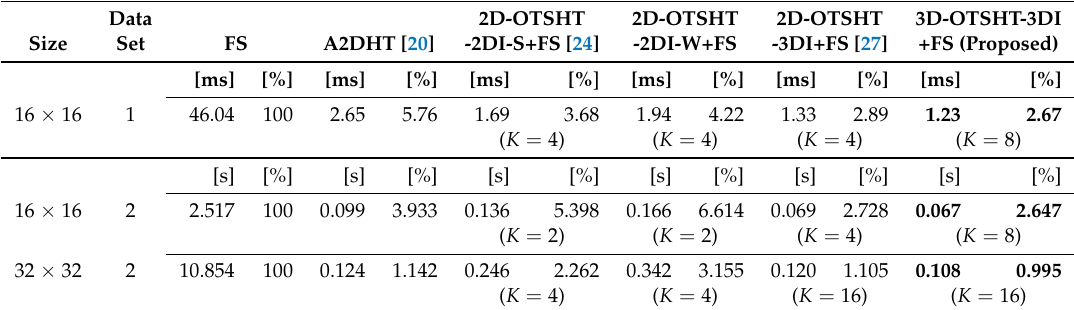
Table 6. Mean elapsed time and ratio to FS time for patches of size